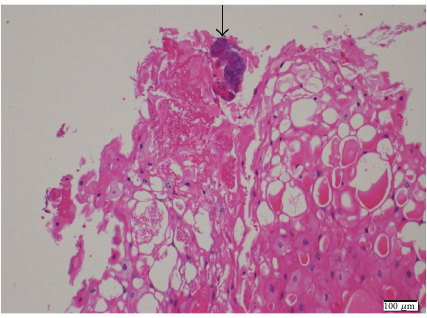
Figure 2: Microscopically, specimen demonstrated vocal cord actinomycosis (hematoxylin and